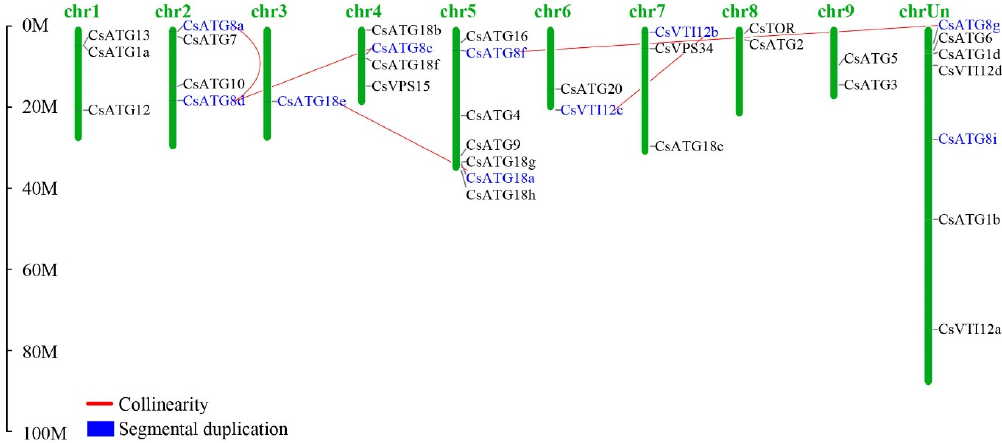
Figure 2. Chromosomal distribution and gene duplication of CsATG genes. The genes highlighted with blue color represent segmental duplications. The pairs linked with red lines represent collinear genes.